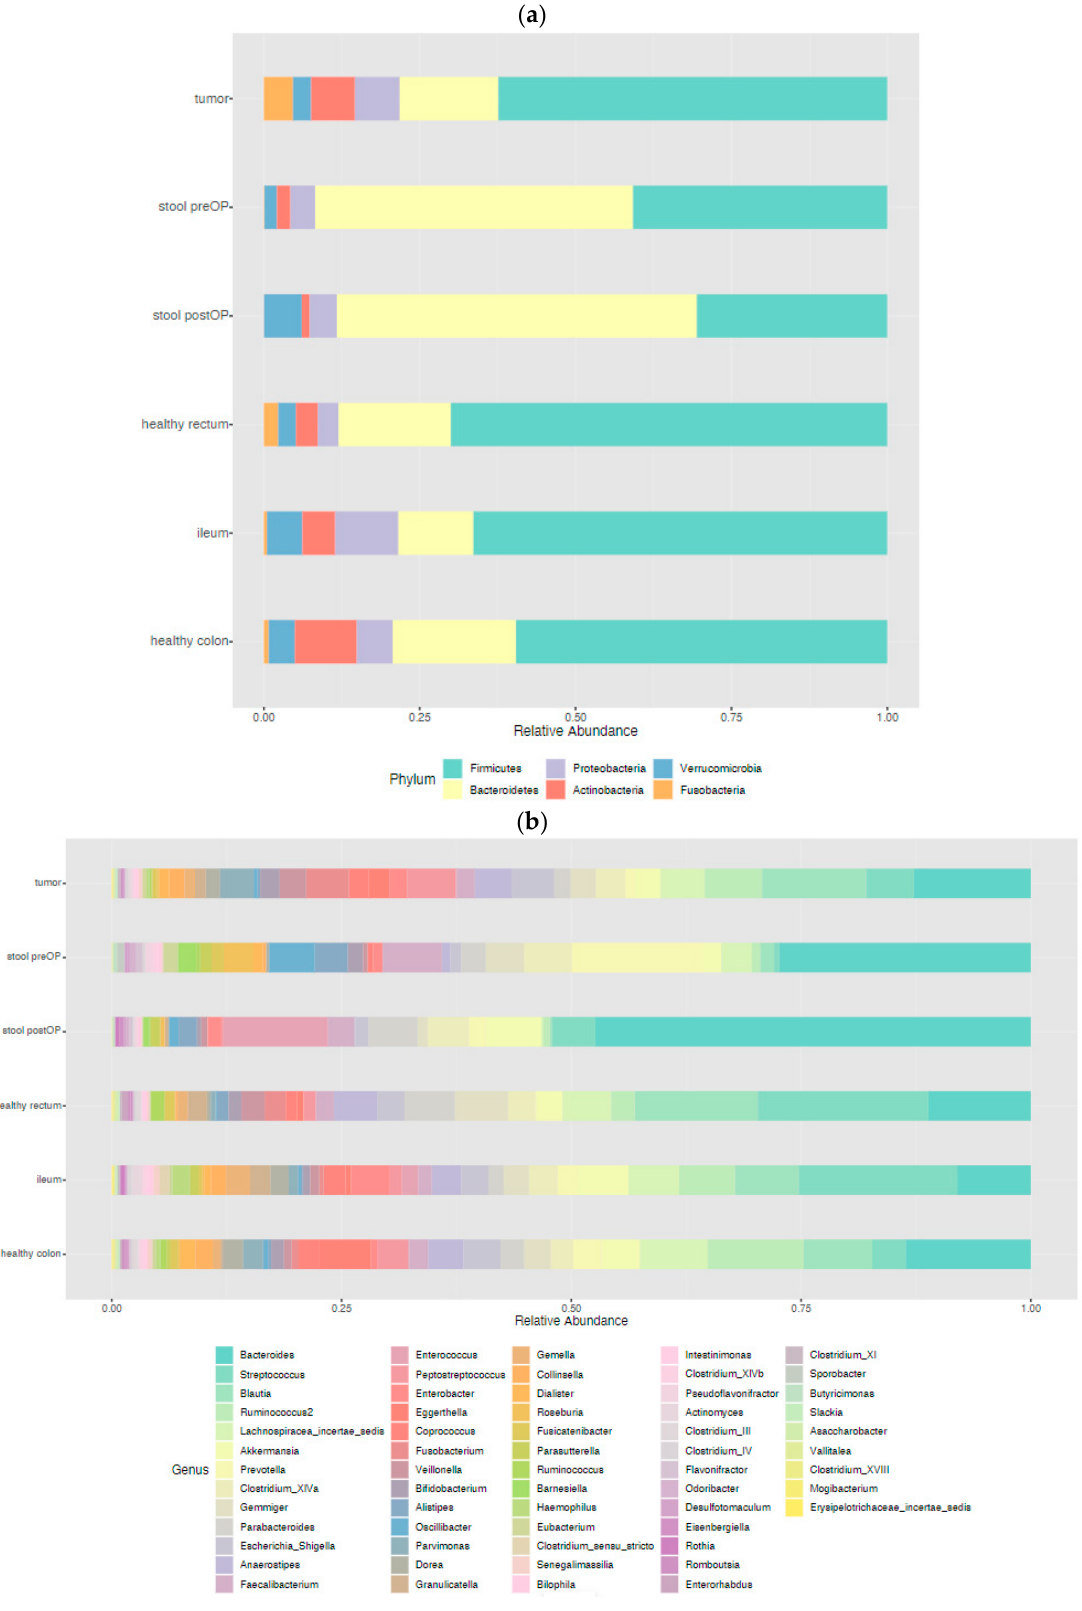
Figure 1. Taxonomic analysis of the microbiome in the different habitats of CC patients: represented at the phylum level ( a ) and genus level ( b ).